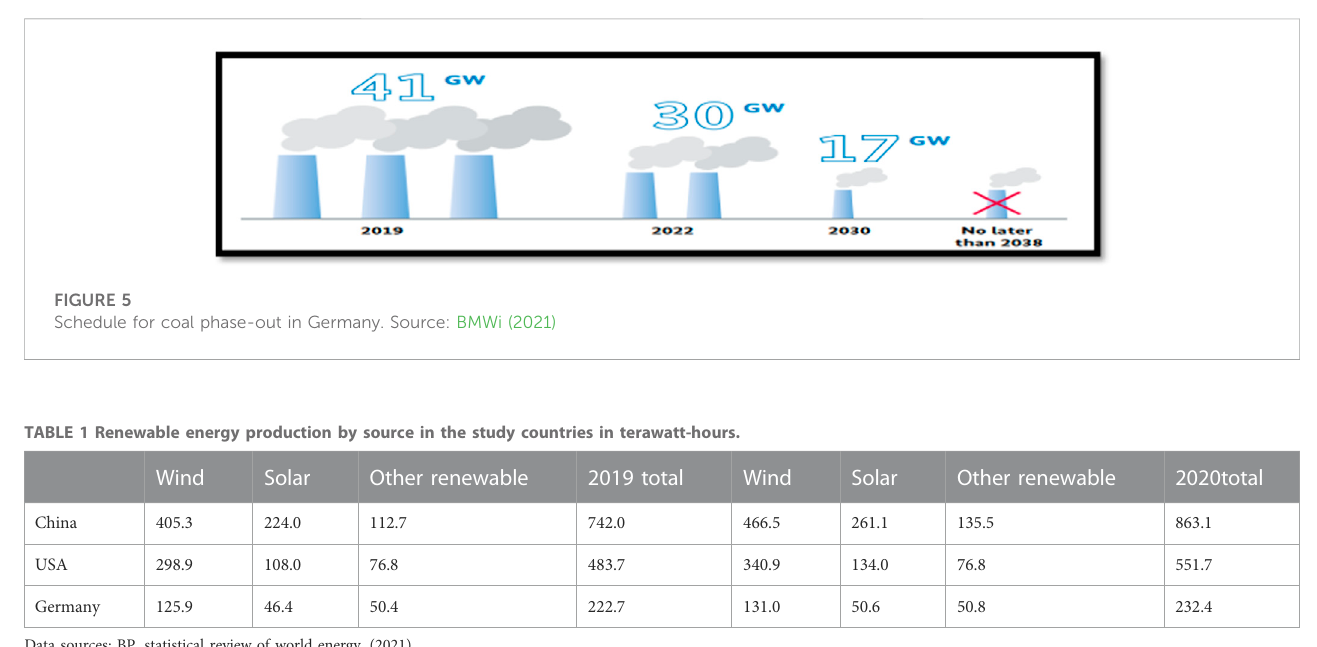
Data sources: BP, statistical review of world energy, (2021).